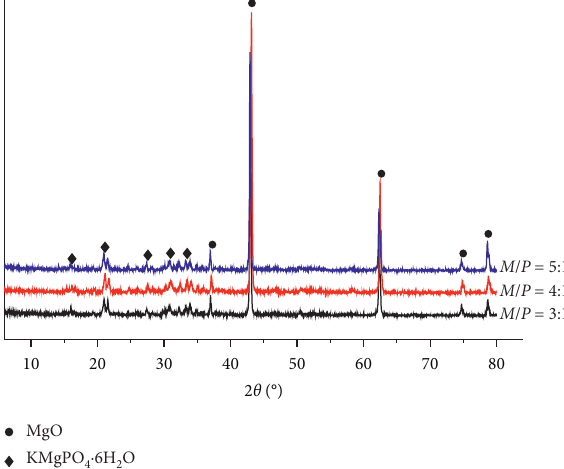
Figure 10: XRD patterns of the samples with the M / P mass ratios of 3 :1, 4 :1, and 5:1 cured under air-curing conditions for 28d.